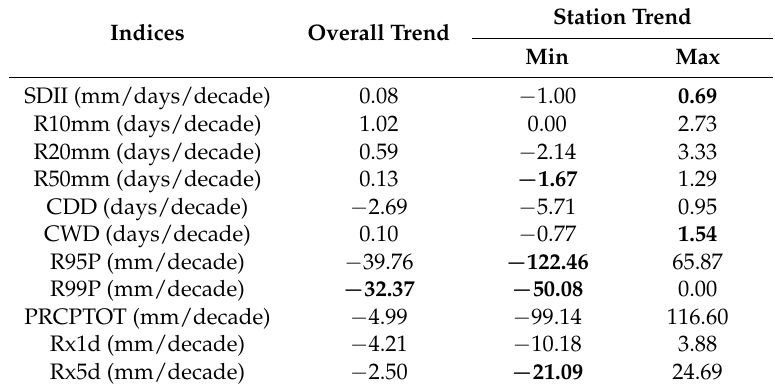
Table 4. Magnitude of the annual precipitation extreme indices from 1985 to 2015. Bold color indicates significant trend at a 95% significance